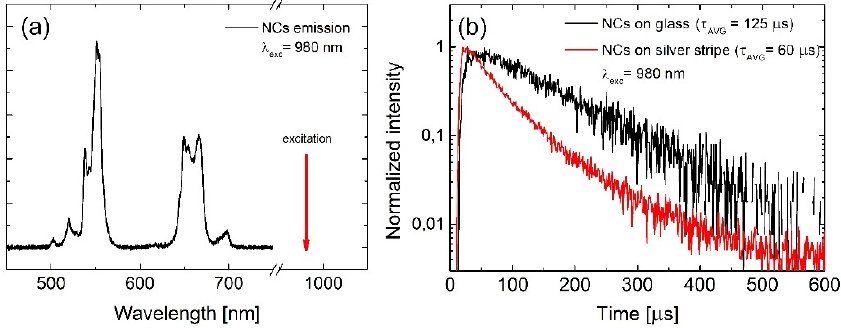
Figure 4. ( a ) Absorption and emission spectra of NaYF 4 :Er 3+ /Yb 3+ nanocrystals. ( b ) Photoluminescence transients acquired for nanocrystals deposited on glass (black line) and silver stripes (red